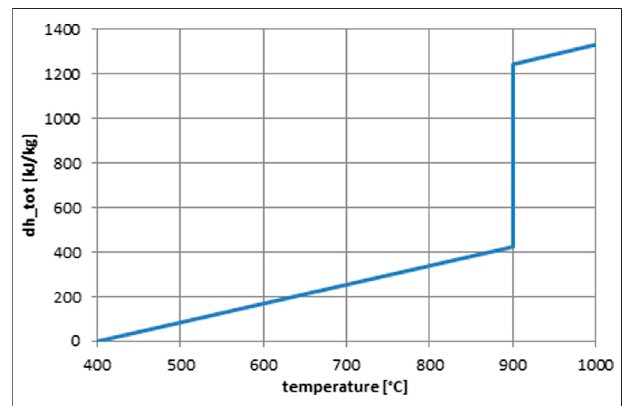
FIGURE 3 | Enthalpy data for bauxite material (as reference). FIGURE 4 | Enthalpy data for cobalt-based redox material.